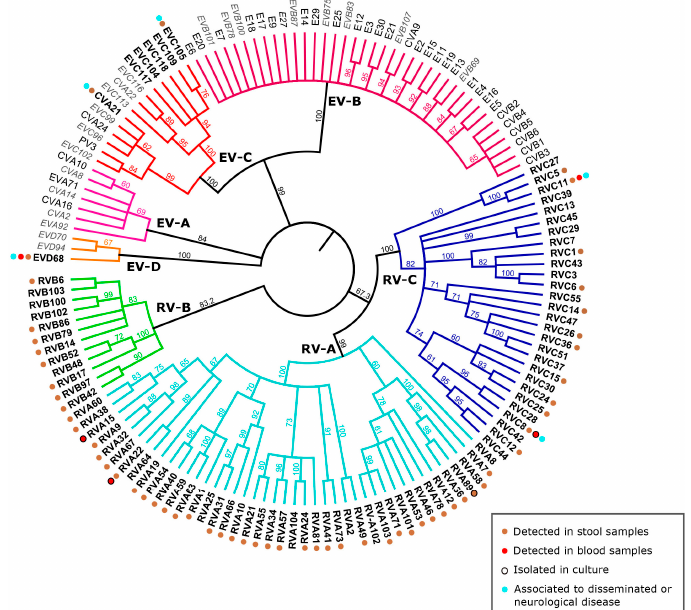
Figure 2. Phylogeny of the different human enterovirus species with emphasis on respiratory enteroviruses and associated clinical features. The VP1 nucleotide region of selected representatives of RV-A to -C and EV-A to -D species including all non-RV EVs associated with respiratory disease (Table 1) were included in the phylogenetic analysis with simian sapelovirus 1 (SSV-1) as the outgroup (see Table S1 for Genbank IDs). The tree was computed as previously described [6]. The consensus tree resulting from PhyML analysis is shown as cladogram. Names of viruses detected predominantly or exclusively in respiratory samples are in bold, names of viruses detected occasionally in respiratory samples are in black while names of non respiratory EVs are in light grey and italic. Clinical features associated with viruses predominantly detected in respiratory samples are color-coded. The references for each unusual associated symptom or detection site are available in Table S2.